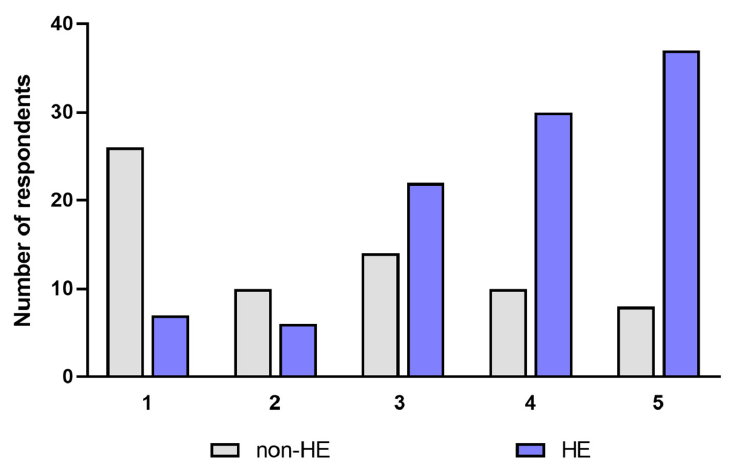
Figure 24. Assessment of the quality of life associated with hand disinfection in both groups (HE- study group and non-HE) during the pandemic. 1-disinfection had no negative effect on the quality of life, 5–disinfection had a significant impact by lowering quality of life.